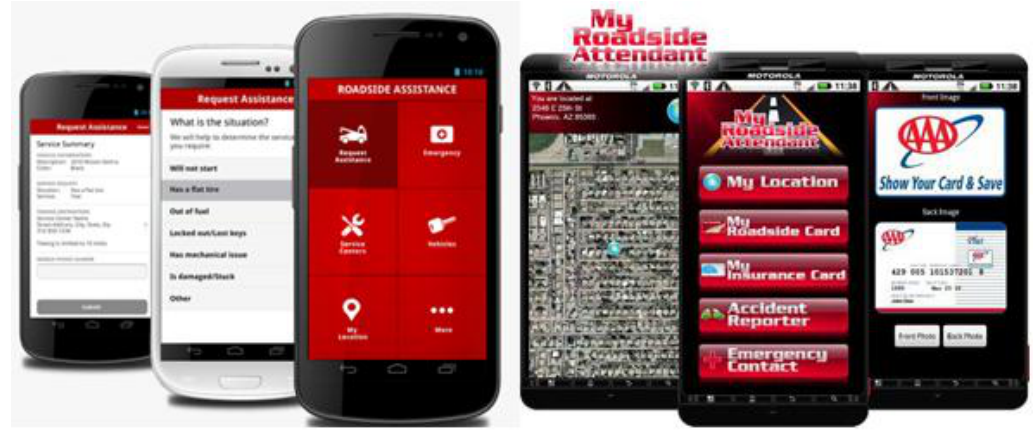
Figure 6. Real-time Roadside Assistance Apps. Image credit: Verizon [57] and AAA